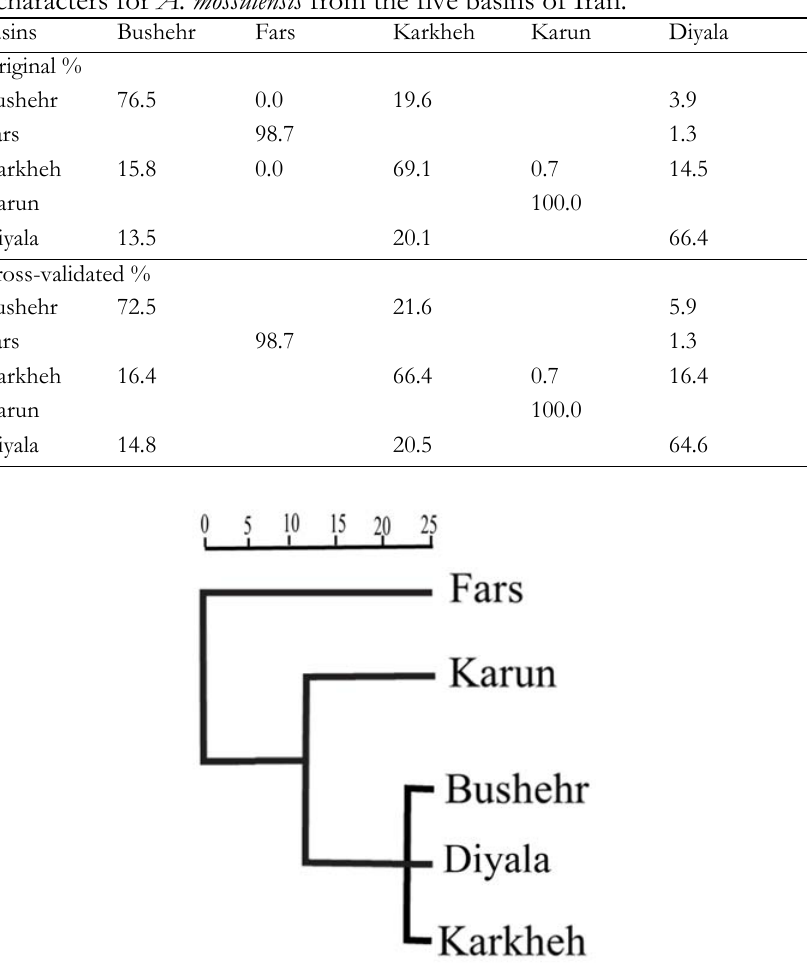
F IGURE 4. Dendrogram derived from cluster analyses of 21 morphometric characters on the basis of Euclidean distance for A. musselensis